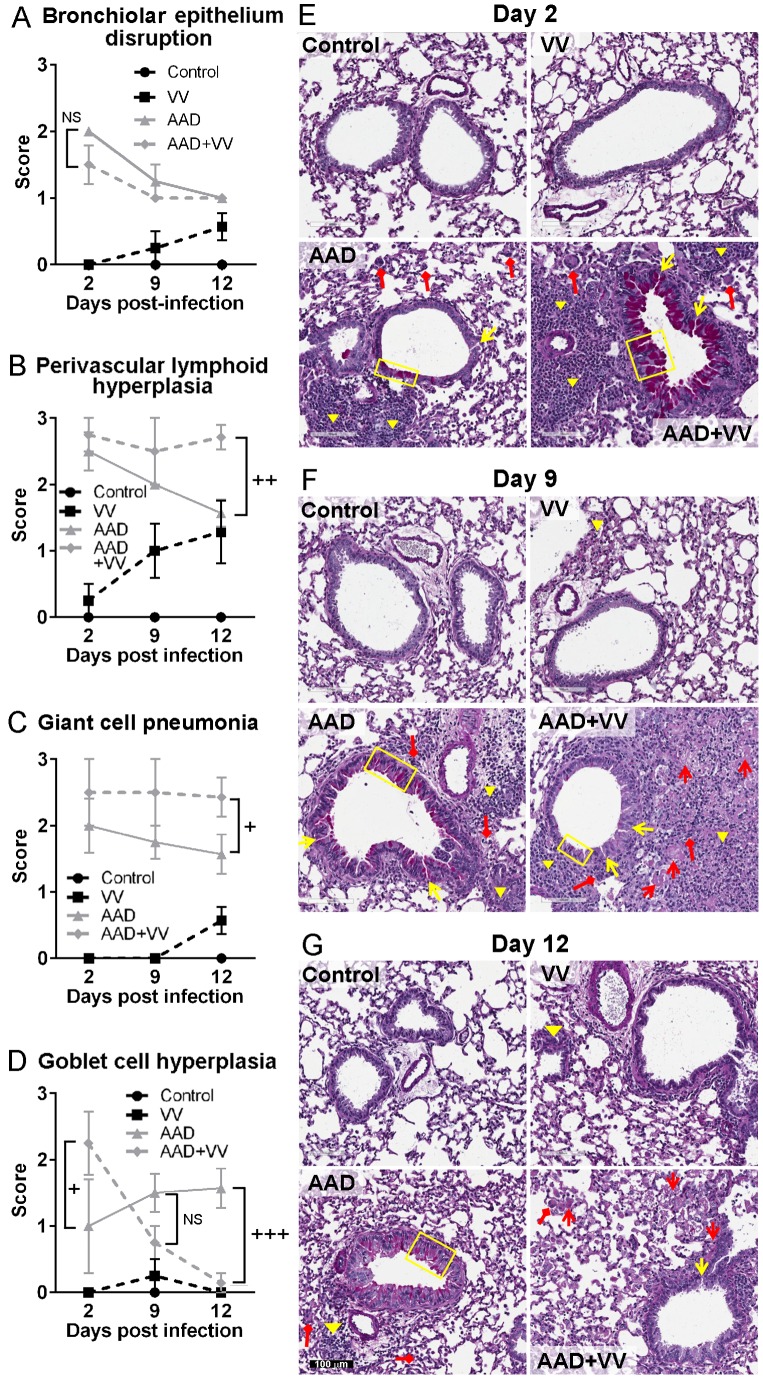
AAD caused increased epithelium disruption and cellular hyperplasia regardless of VV infection.Murine lung tissue was fixed in 10% formalin and paraffin-embedded sections were stained with PAS/hematoxylin and blindly scored for several pathophysiological parameters using a semi-quantitative scale of 0–3. Mice with AAD had (A) increased bronchiole epithelium disruption (yellow arrow) in the airways, (B) increased perivascular lymphoid hyperplasia (yellow inverted triangle), and (C) increased giant cell pneumonia (red diamond-headed arrow) at 2 and 9 dpi. (D) Goblet cell hyperplasia (yellow box) was significantly increased in AAD+VV mice at 2 dpi, but significantly decreased at 12 dpi compared to AAD mice. (E–G) PAS/hematoxylin-stained slides were digitally imaged with the Aperio Scan Scope CS system at 20× magnification. Multifocal necrotizing pneumonia is evident in the AAD+VV mice at 9 and 12 dpi as diffuse pink staining in the lung parenchyma (red arrow). Statistical significance was determined by a Two-way ANOVA with Bonferroni’s multiple comparisons test: NS - not significant, +
P<0.05, ++
P<0.01 +++
P<0.001 AAD+VV vs. AAD.